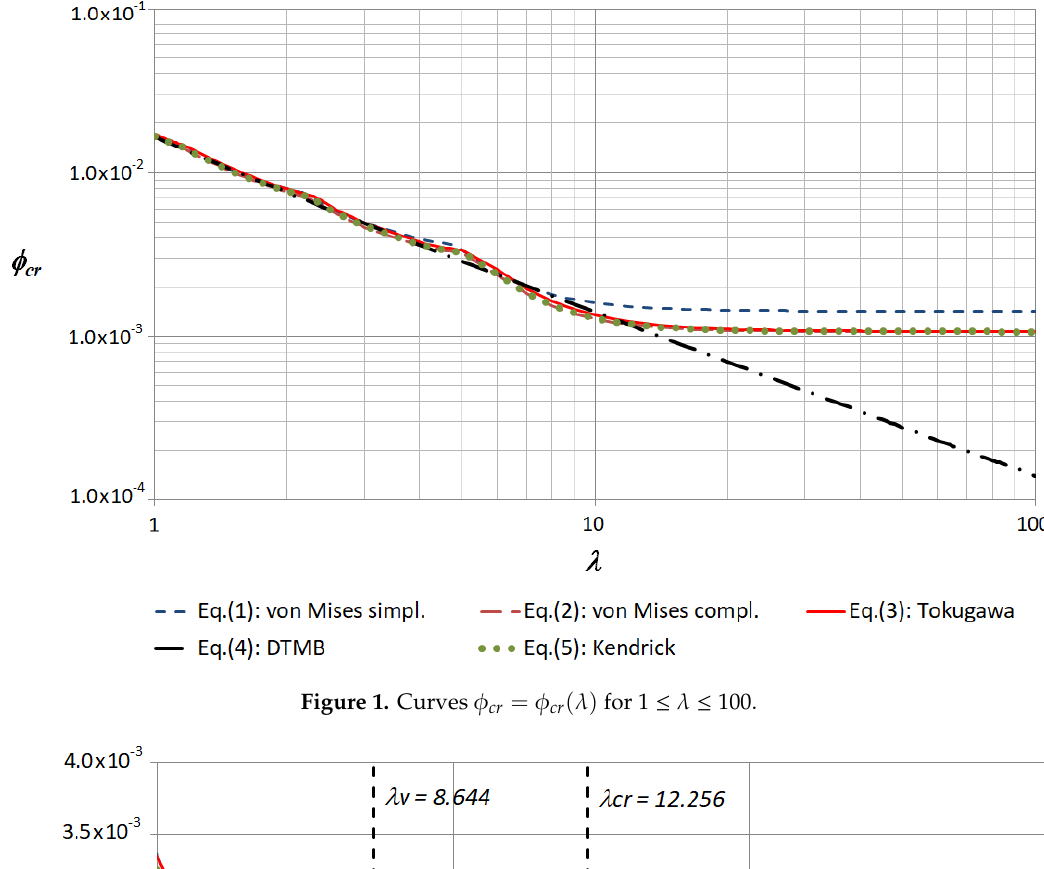
Figure 1. Curves  Figure 1. Curves φ cr = φ cr ( λ ) for 1 ≤ λ ≤ 100.